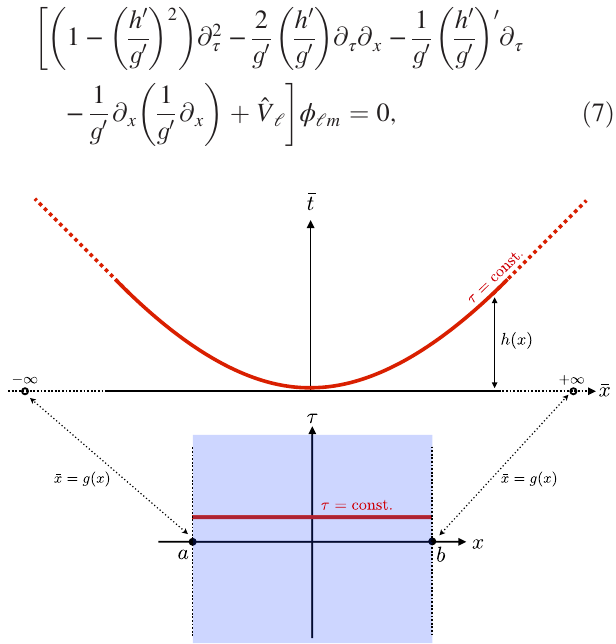
FIG. 2. Schematic representation of the hyperboloidal coordi- nate transformation in Eq. (6). Top panel: Dimensionless Schwarzschild time and tortoise coordinates ð ¯ t; ¯ x Þ . The height function h ð x Þ bends the time slices so that future null infinity (and/or the black hole horizon) is reached in the limit ¯ x → (cid:4) ∞ . Bottom panel: Spatially compactified hyperboloidal coordinates ð τ ; x Þ . The compactification function g ð x Þ maps the infinite domain ¯ x ∈ (cid:3) − ∞ ; ∞ ½ onto the finite interval x ∈ (cid:3) a; b ½ . Points b and a are added at the boundary, representing null infinity I þ and/or the BH horizon. The blue stripe shows the domain of integration of the wave equation in Eq. (7) in these compactified hyperboloidal coordinates, namely, ð τ ; x Þ ∈ (cid:3) − ∞ ; þ ∞ ½ × ½ a; b (cid:3) , corresponding to the full original domain ð ¯ t; ¯ x Þ ∈ R 2 of Eq.